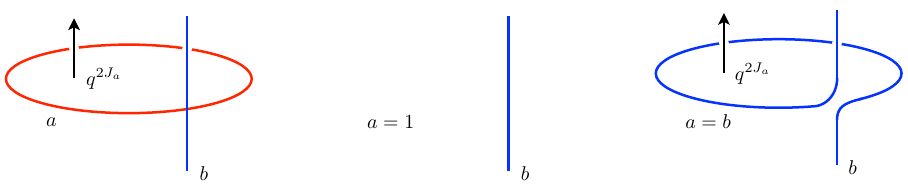
Figure 21 . Twisted transfer matrix in the a -th irrep for a length one spin chain with spin in the b -th irrep of SU(2). When a = 1 the trace is empty while when a = b and for a speci(cid:12)c choice of the rapidity it opens